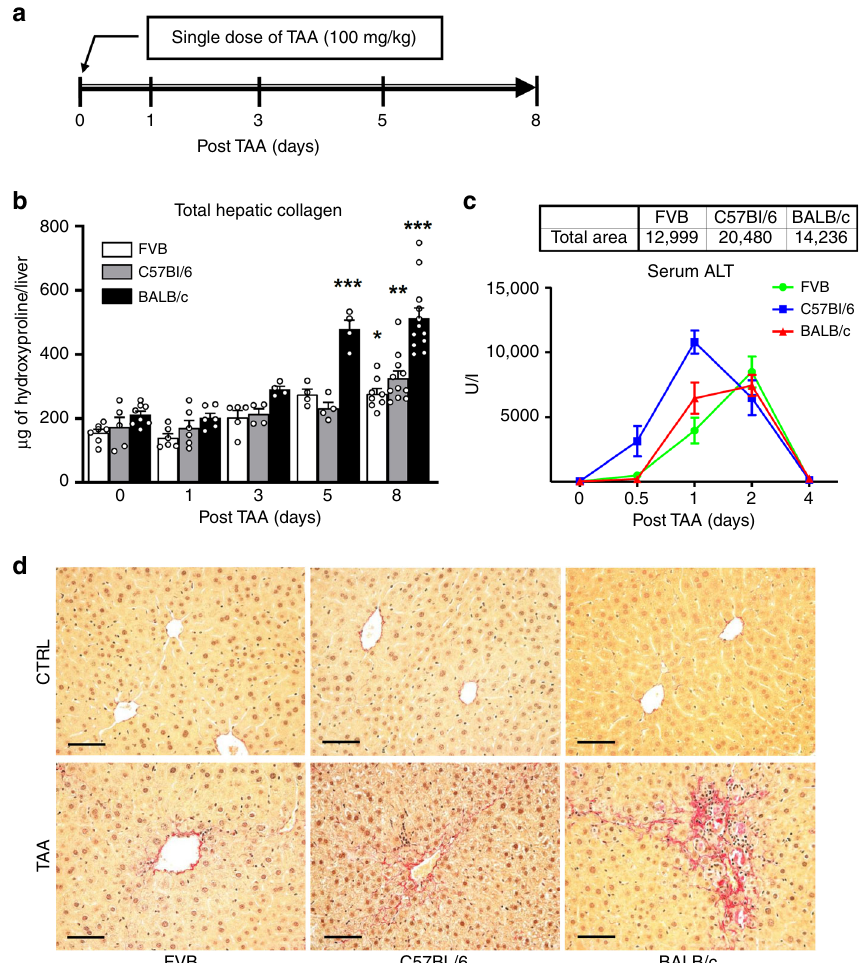
Fig. 1 Fibrotic responses to acute TAA-induced hepatocyte injury recapitulate strain differences in fi brosis susceptibility (BALB/c > C57Bl/6 > FVB) in chronic liver fi brosis model. a Experimental design of acute TAA-induced incipient liver fi brosis model in mice. Injury and wound healing responses